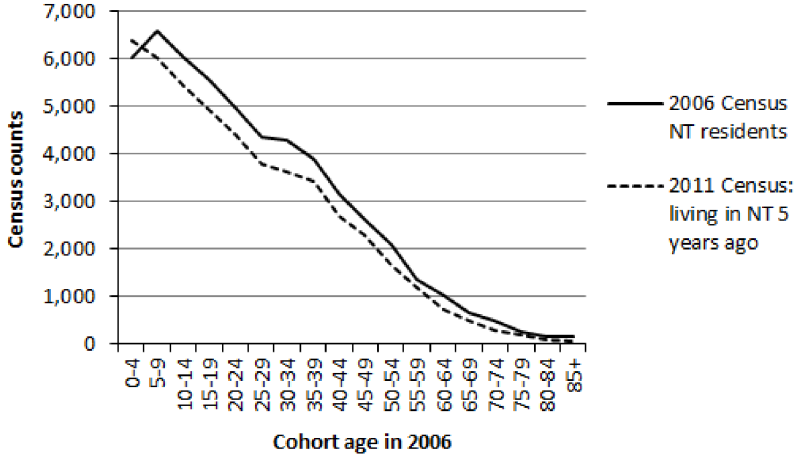
Figure 4. Comparison of Northern Territory (NT) Indigenous census counts in 2006 with 2011 Census counts of Indigenous persons living in the Northern Territory 5 years earlier.